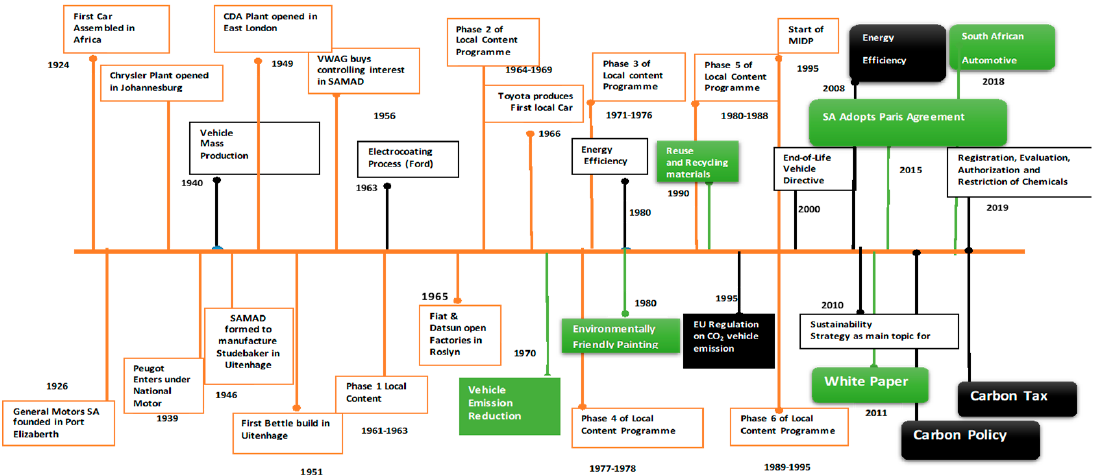
Figure 1. Global and South African automotive revolution began in 1924, with emergence of energy consumption and carbon emission regulations (Source